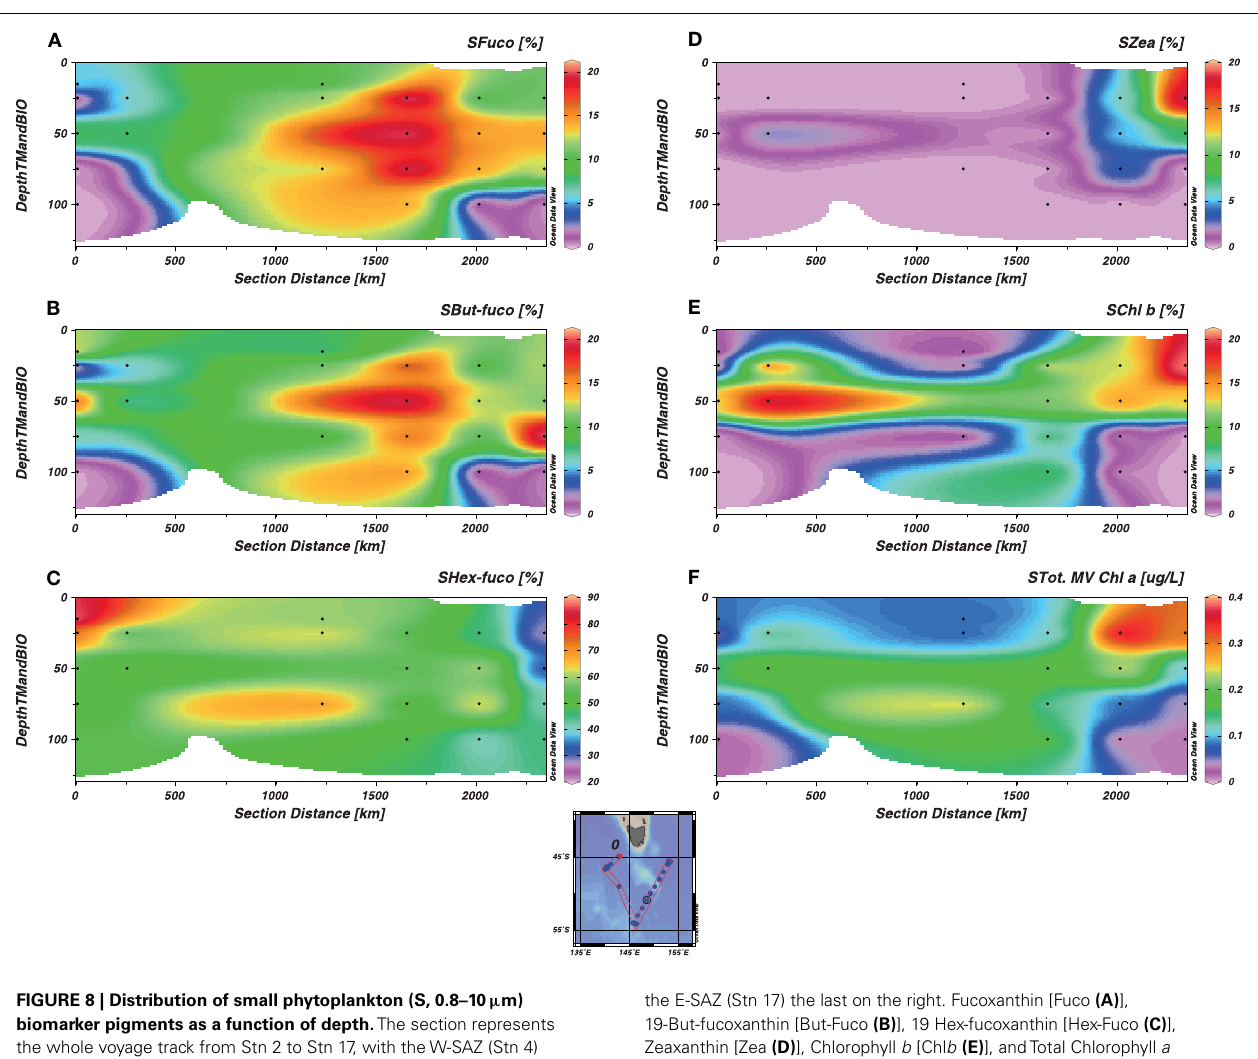
FIGURE 8 | Distribution of small phytoplankton (S, 0.8–10 µ m) biomarker pigments as a function of depth. The section represents the whole voyage track from Stn 2 to Stn 17, with theW-SAZ (Stn 4) being the second station on the left, the PFZ (Stn 6) in the center and